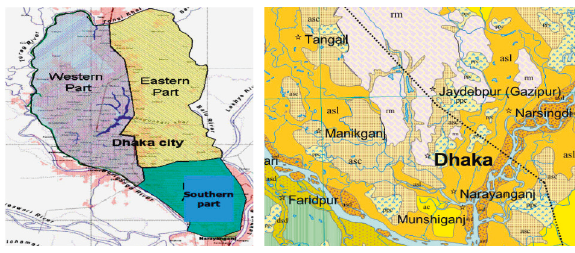
Figure 1: Project site location